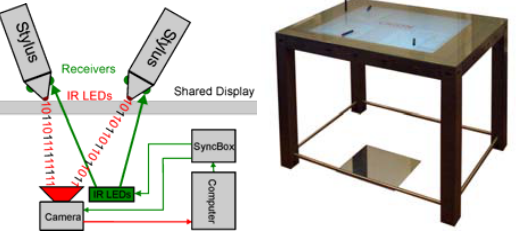
Figure 3. Principle setup of InfrActables and its realization